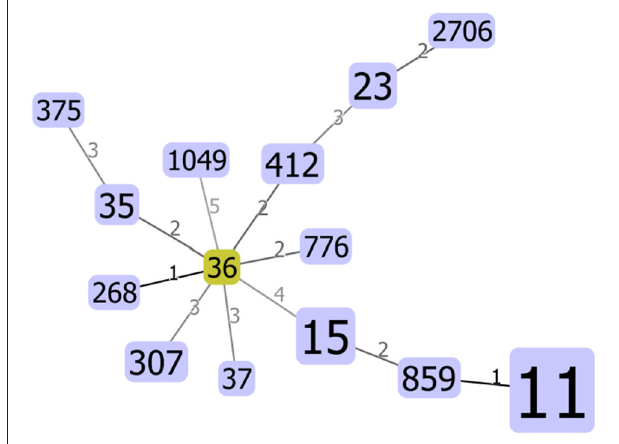
FIGURE 1 | Minimum spanning tree (MST) constructed based on diversity of seven housekeeping genes of Klebsiella pneumoniae . The area of each circle corresponded to the prevalence of the sequence type (ST) in the multilocus sequence typing (MLST) data of this